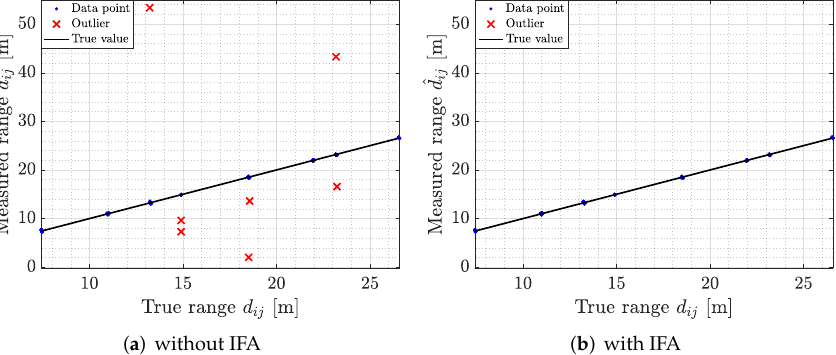
Figure 5. Outlier filtering by the proposed 1D IFA: ( a ) range measurements before outlier filtering and ( b ) after outlier